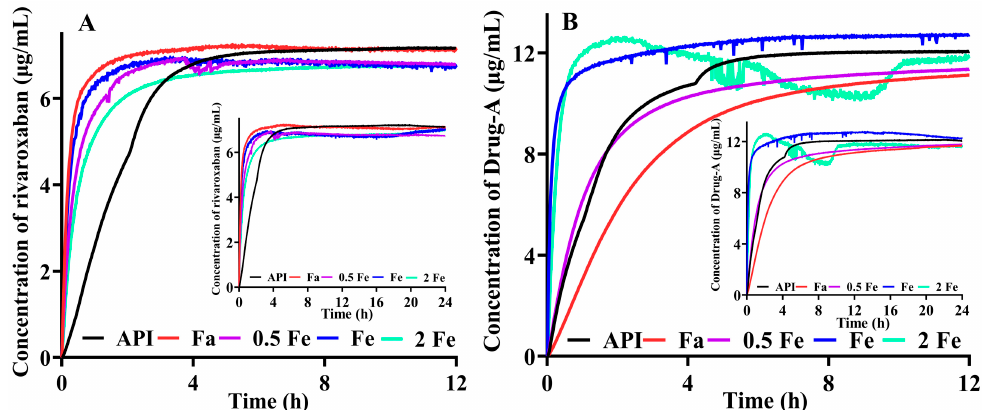
Figure 4. DSC thermogram of different precipitates. ( A ): Rivaroxaban; ( B ): Drug-A. (API-Acid/API-ACN, FaB, FeB, Fa, 0.5 Fe, Fe, and 2 Fe indicate that precipitate comes from the medium of organic solvent, FaSSIF buffer, FeSSIF buffer, FaSSIF, 0.5 × FeSSIF, FeSSIF, and 2 × FeS- SIF, respectively).